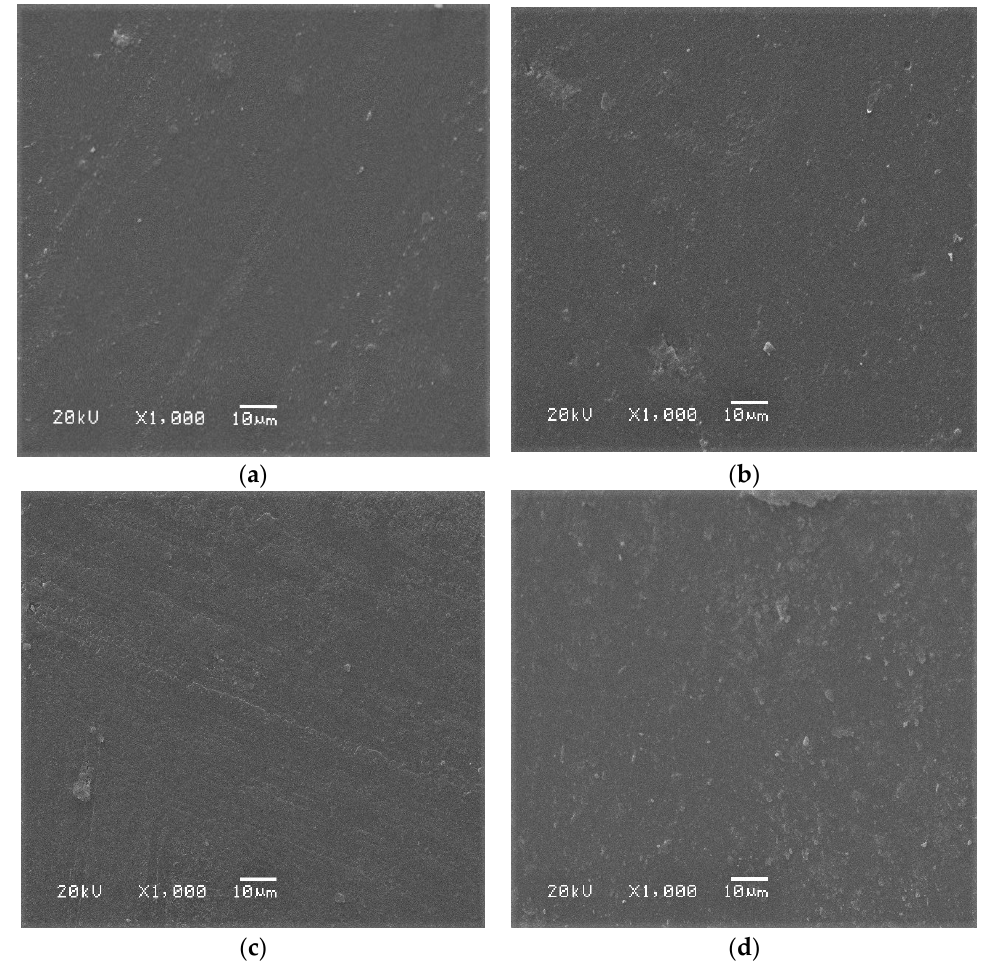
Figure 3. SEM images of ( a ) aminochitosan, ( b ) quaternized aminochitosan 1, ( c ) quaternized ami- nochitosan 2 and ( d ) quaternized aminochitosan 3 membranes. aminochitosan 2 and ( d ) quaternized aminochitosan 3